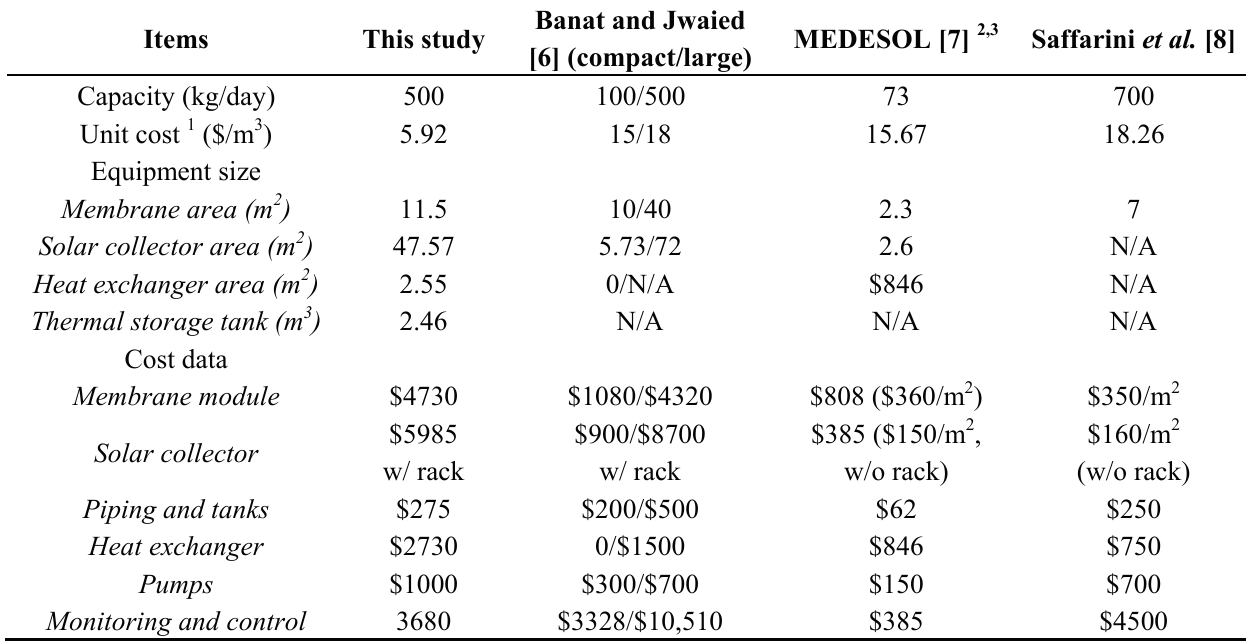
Table 5. Comparison of equipment sizes and cost data for